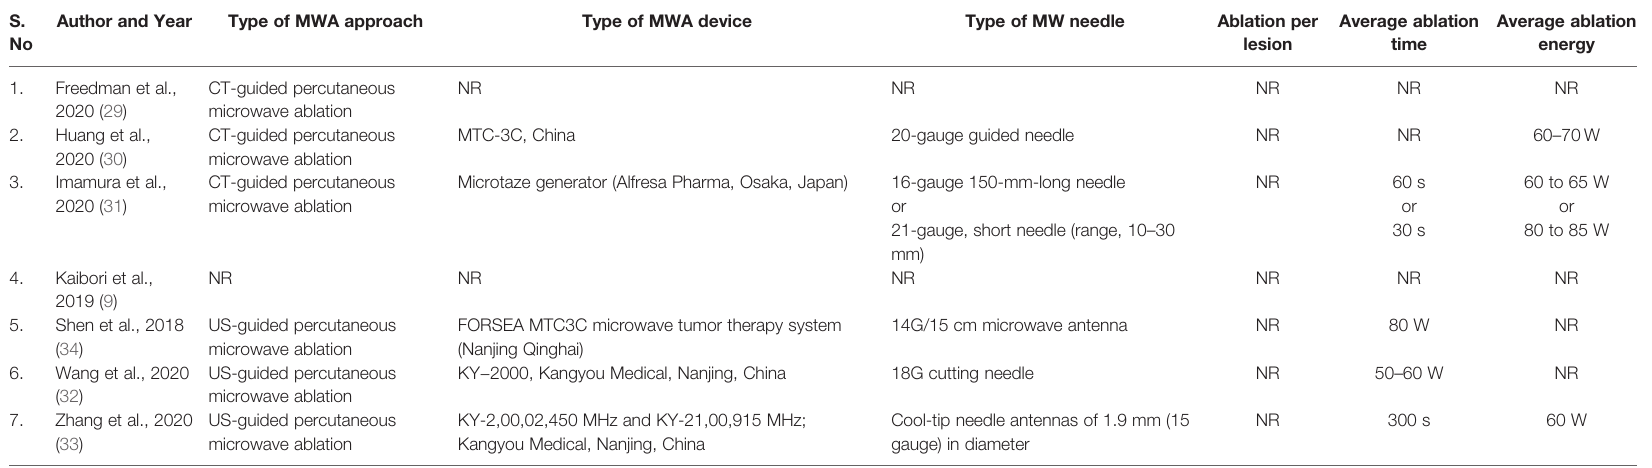
TABLE 4 | Detailed MWA characteristics of included studies in the systematic review investigating microwave ablation for hepatocellular carcinoma in elderly